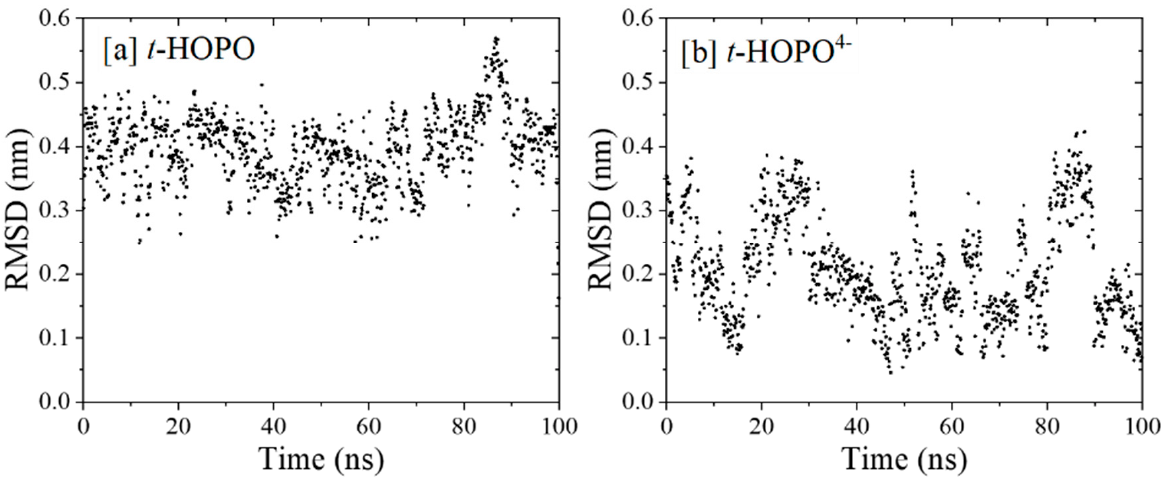
Figure 1. Time evolution of atomic positional RMSD of ( a ) t -HOPO and ( b ) t -HOPO 4 − . All non-hy- drogen atoms were considered in the calculations, and the central structure of the most populated cluster (rank 1) in each simulation was used as the reference. The time evolution of RMSD with the starting structure as the reference is provided in the Supporting Information (Figure S1).